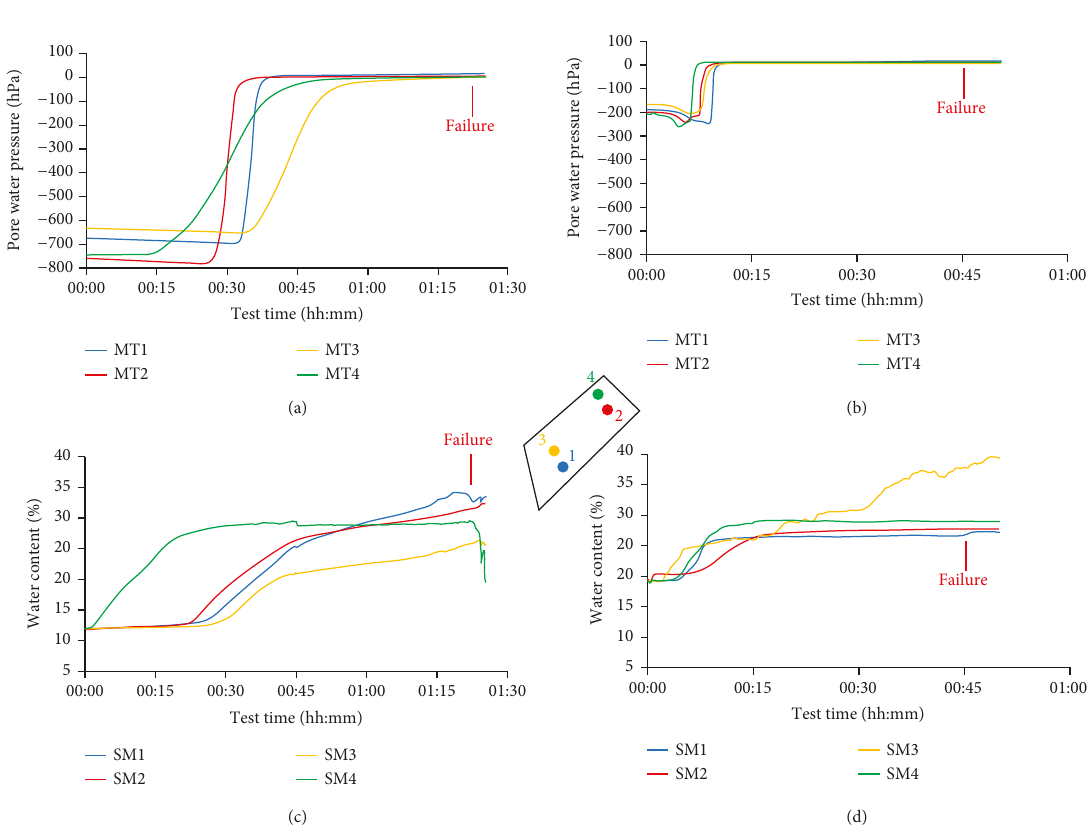
Figure 7: Temporal evolution of failure during test n.3.